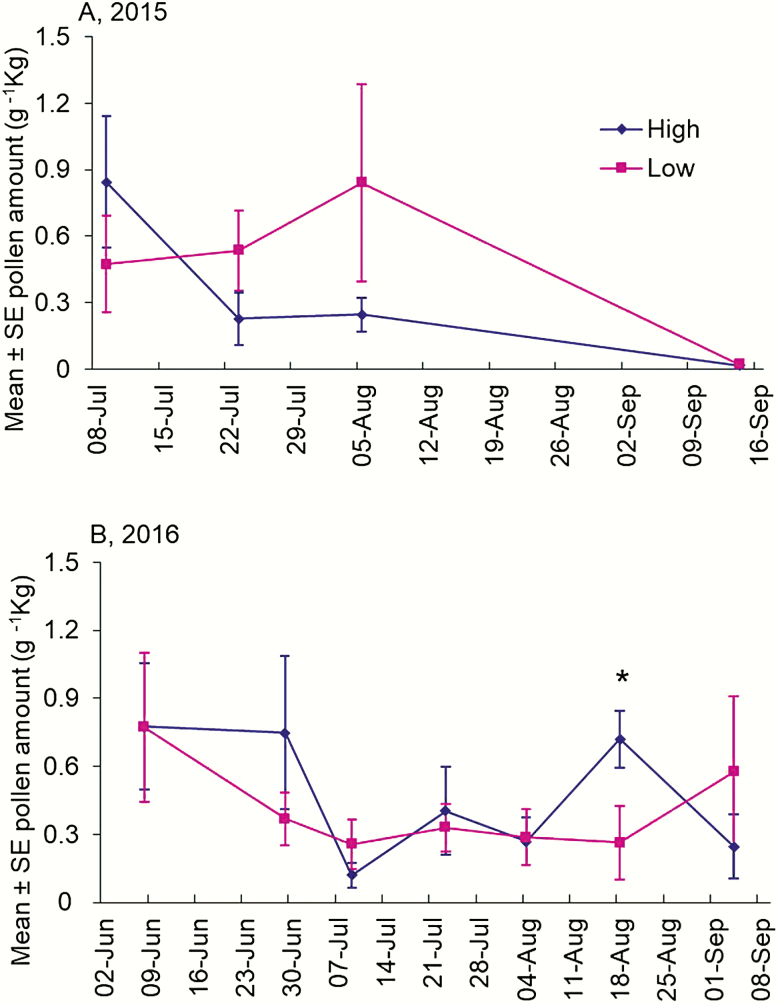
The abundance of pollen collected by honey bees in high and low cultivation landscapes of central Iowa during 2015 (A) and 2016 (B). The weight (g) of pollen collected was normalized by net colony weight (kg), resulting in the use of g−1kg along the y-axis. Pollen abundance did not statistically differ between the two landscape categories (Table 2). Note this analysis was conducted on a subset of dates that included only days when colony weight was measured (excluding the pollen data without available corresponding colony weight for normalization). * Indicates a statistically significant difference on a single date by least square means under the mixed effects model (P < 0.05).